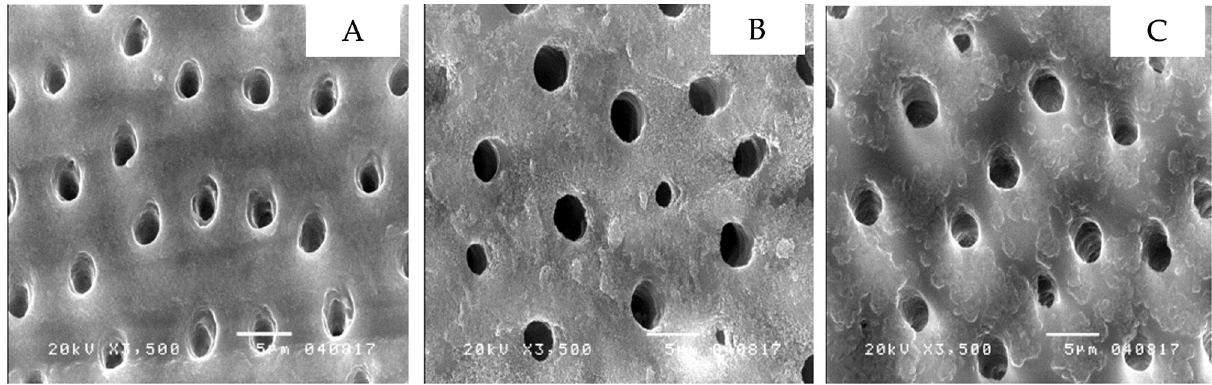
Figure 3. The dentin micro-morphology with 37.5 percent phosphoric acid applied to demonstrate an absence of a smear layer or smear plug, widely opened dentinal tubules, and a presence of silica particles as shown in the image: non-contaminated dentin ( A ), dentin contaminated with topical anesthetic solution ( B ), dentin contaminated with topical anesthetic gel ( C